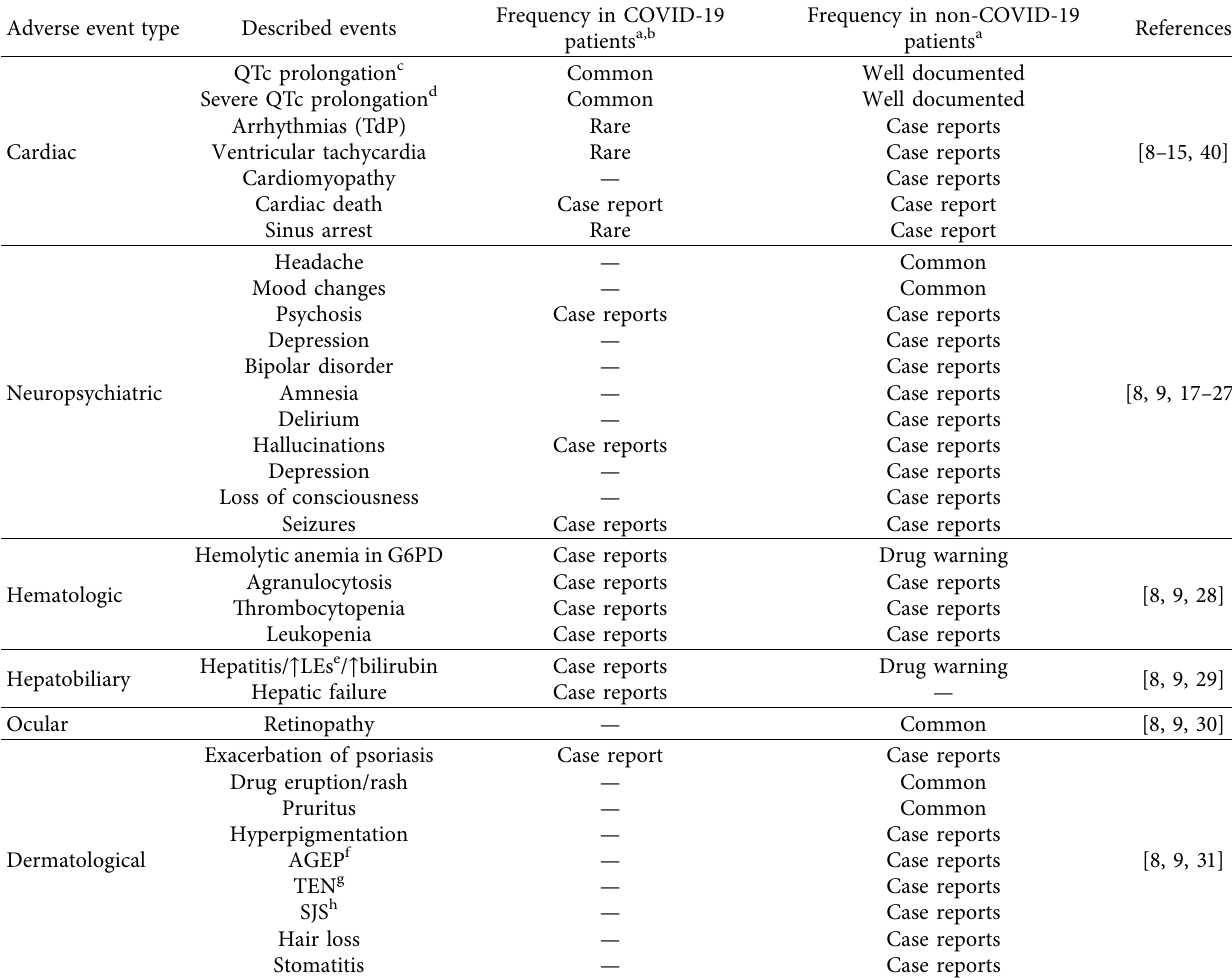
Table 1: Frequency of adverse drug events associated with hydroxychloroquine in COVID-19 and non-COVID-19 patients. Adverse event